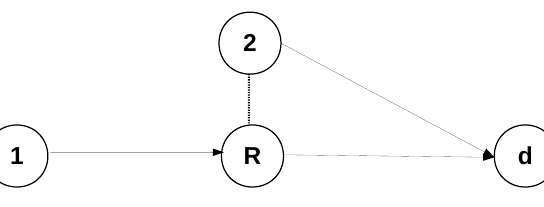
Figure 1. An indicative topology of the considered